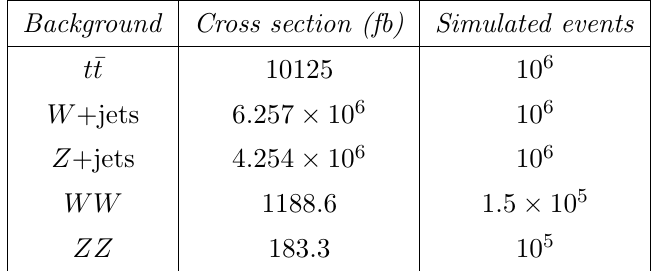
Table 1 . Main backgrounds along with the corresponding cross sections and the number of simu- lated events used for this